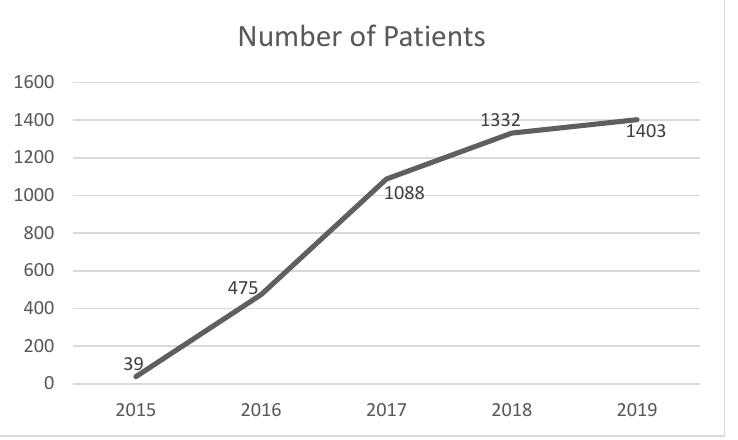
Figure 2. The year-wise number of patients visiting the center for mammography screening pur-